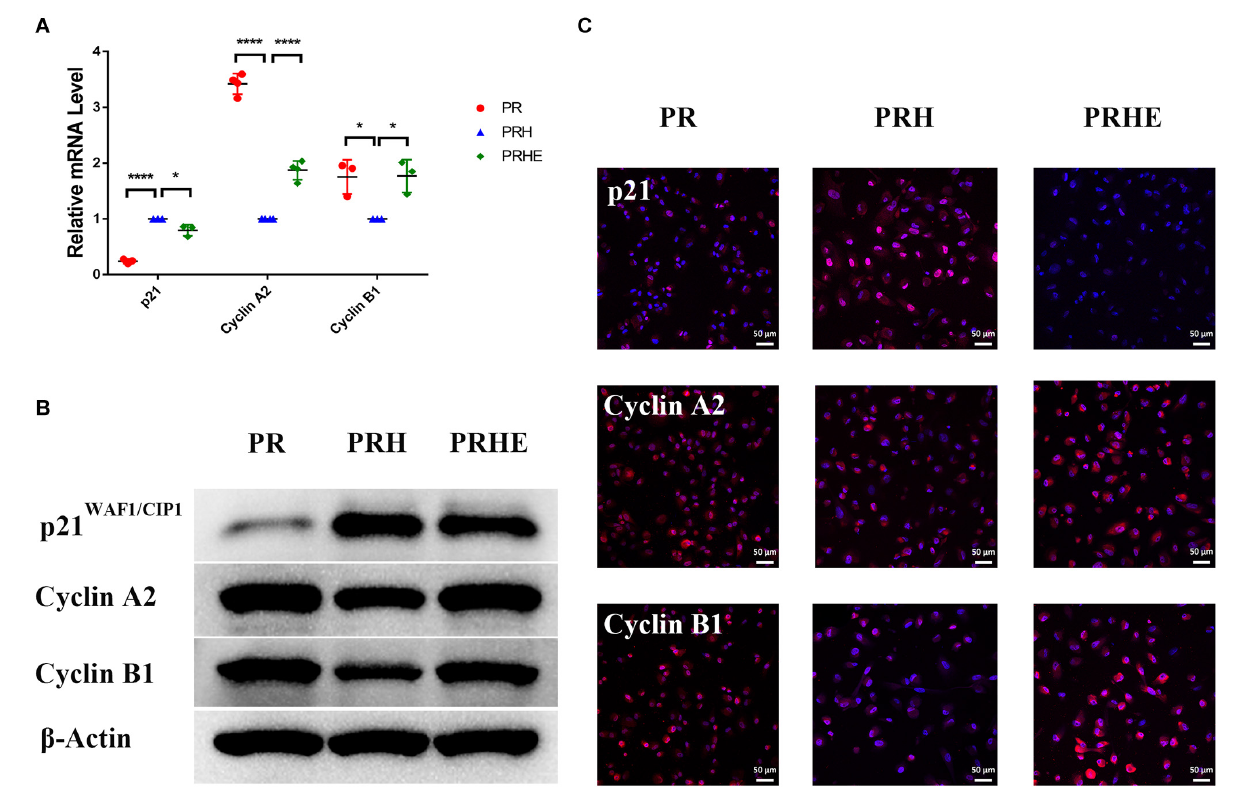
FIGURE 6 | The cocultured ESCs downregulated senescence-related positive markers and upregulated senescence-related negative markers in premature senescent RPE cells. (A) Expression of cellular senescence-related markers in the PR, PRH, and PRHE groups, as assessed by RT- qPCR ( n ≥ 3 biological repeats). (B) Results for cellular senescence-related markers in the PR, PRH, and PRHE groups as determined by western blotting. β -Actin was used as the internal reference. (C) The expression levels of cellular senescence-related markers in the PR, PRH, and PRHE groups as determined by immunofluorescent staining. Scale bar, 50 µ m. Data are presented as the mean ± SD. ∗ P < 0.05; ∗∗∗∗ P < 0.0001.